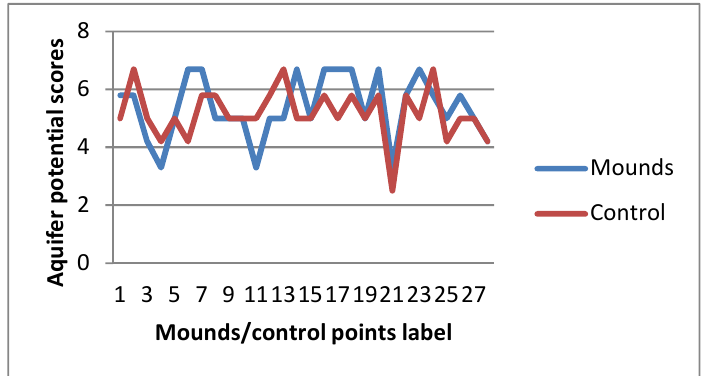
Figure 6. Aquifer potential around termite mounds and control areas.